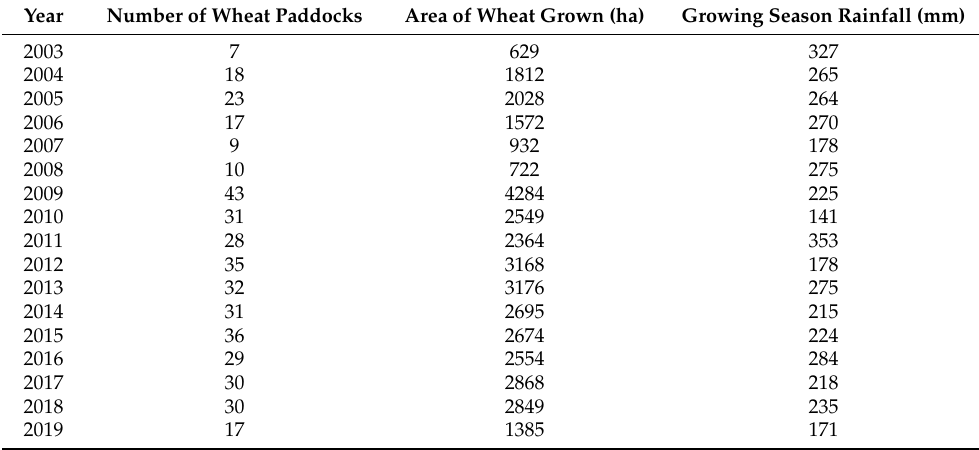
Figure 1. The study area: ( a ) Study area location in the eastern grainbelt of Western Australia; and ( b ) false-colour composites of the near-infrared, red and green bands of the Landsat-8 OLI image acquired 29 August 2019 with 44 paddocks with wheat yield data overlaid in blue. Table 1. Number of wheat paddocks, area of wheat grown and growing season (May to October) rainfall for each year from 2003 to